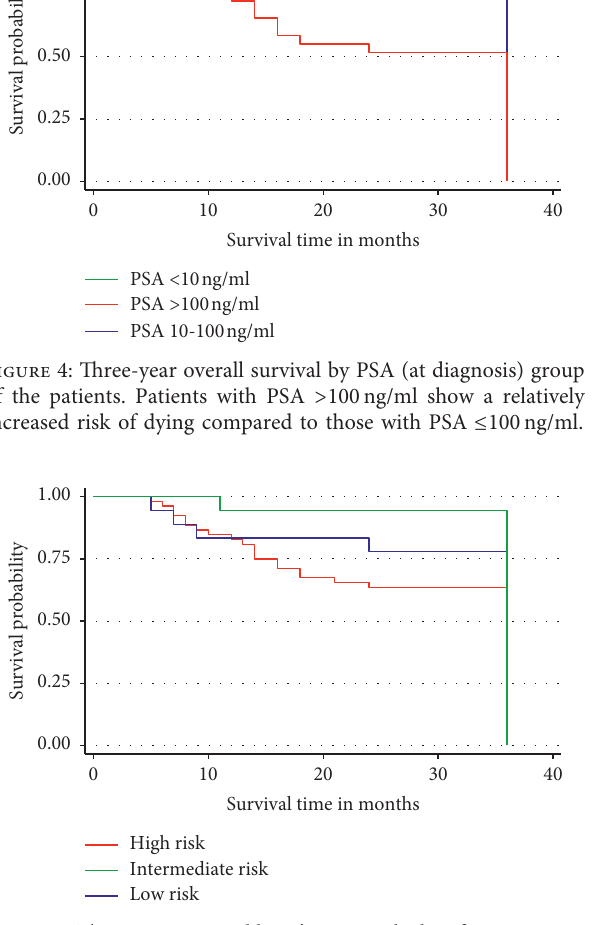
Figure 5: Three-year survival by D’Amico risk classification group of the patients. Patients with high risk show a relatively increased risk of dying compared to those with low and intermediate